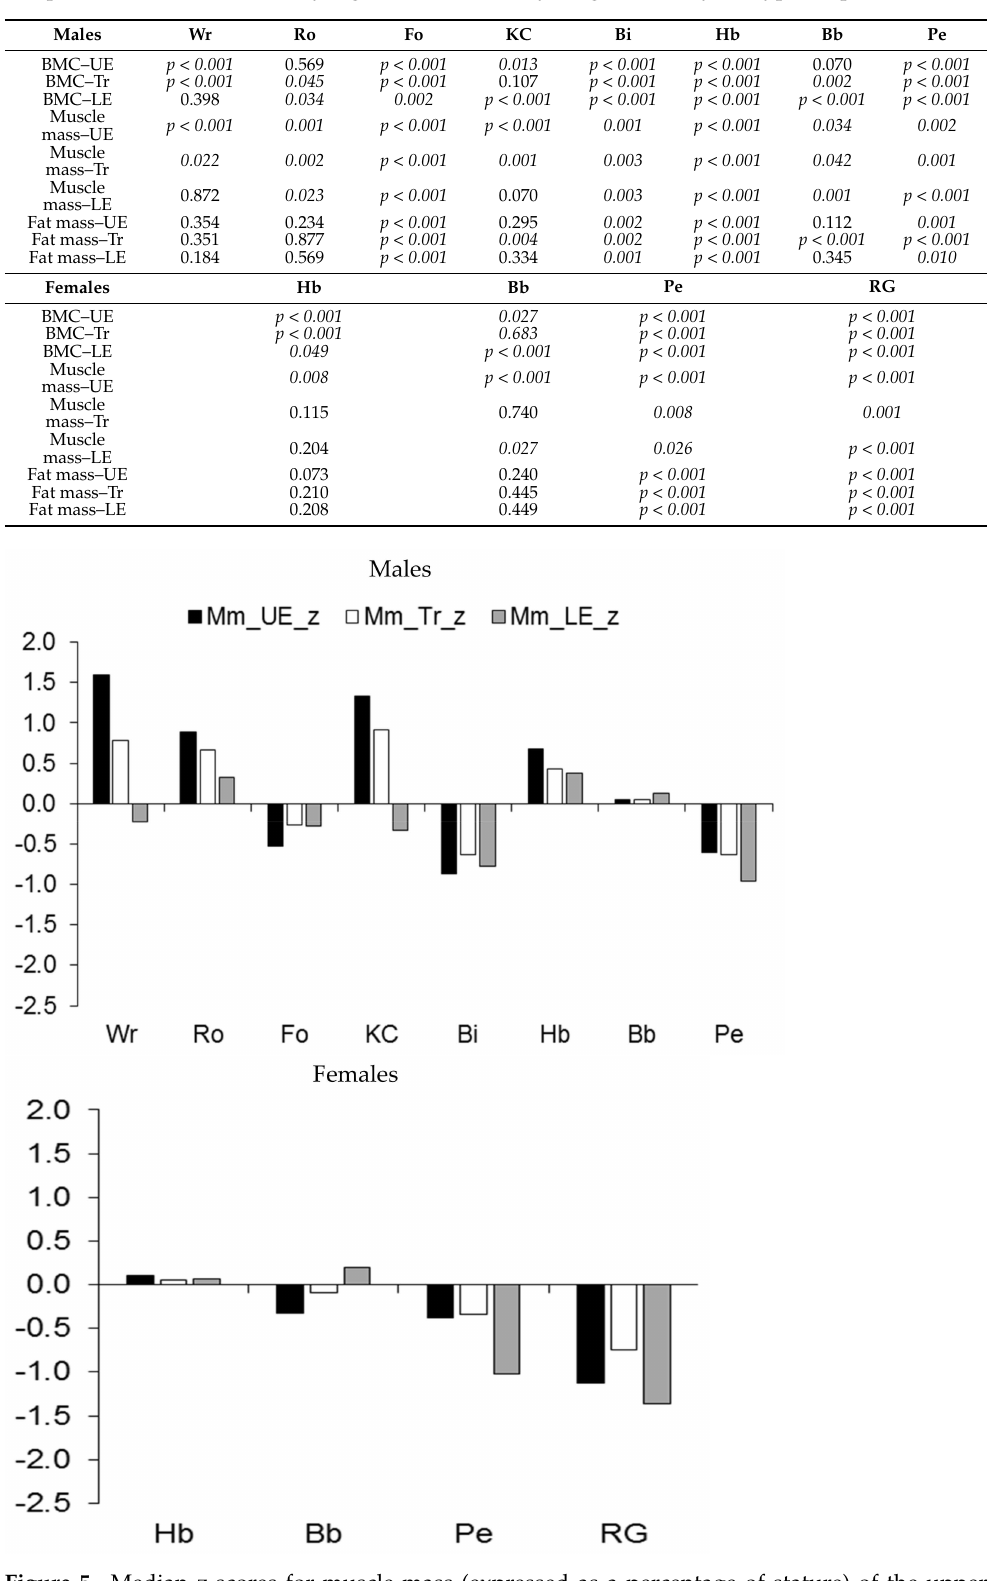
Figure 5. Median z-scores for muscle mass (expressed as a percentage of stature) of the upper extremities (UE), trunk (Tr), and lower extremities (LE) in youth athletes by